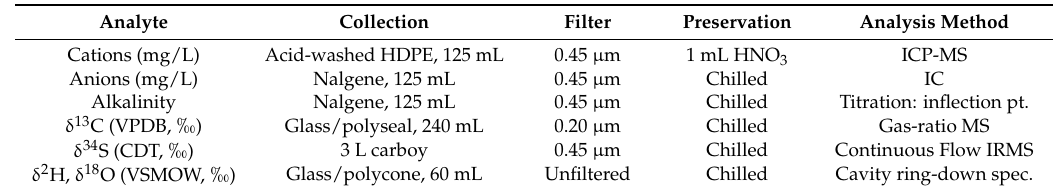
Table 3. Geochemical and isotope analyses of groundwater samples collected from 28 wells in the South Fork Palouse River